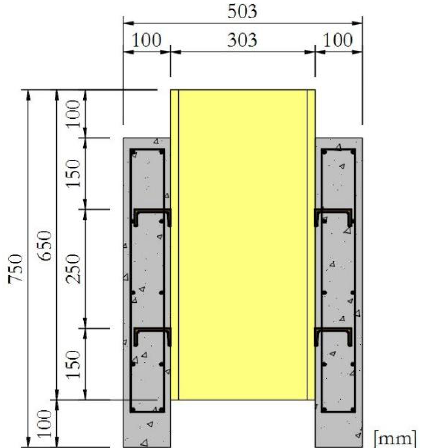
Figure 4. Push-out test models with shear